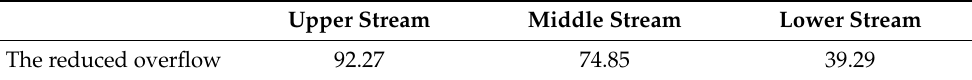
Table 3. The reduced overflow through the blue-green space reconstruction (10 4 m 3